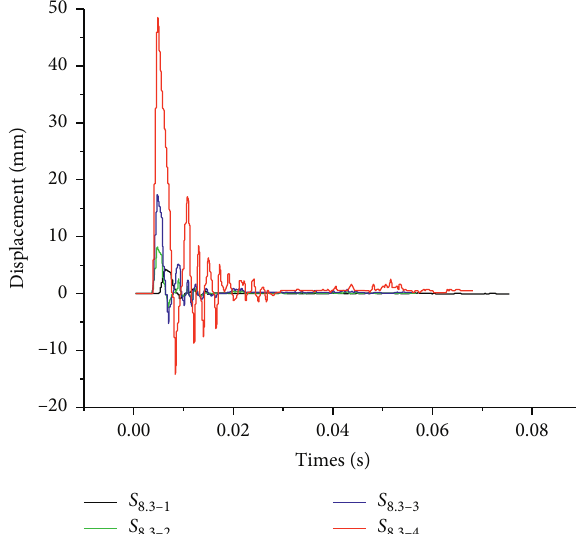
Figure 19: Column top displacement chart of impact forces at different falling heights of the pendulum ball.